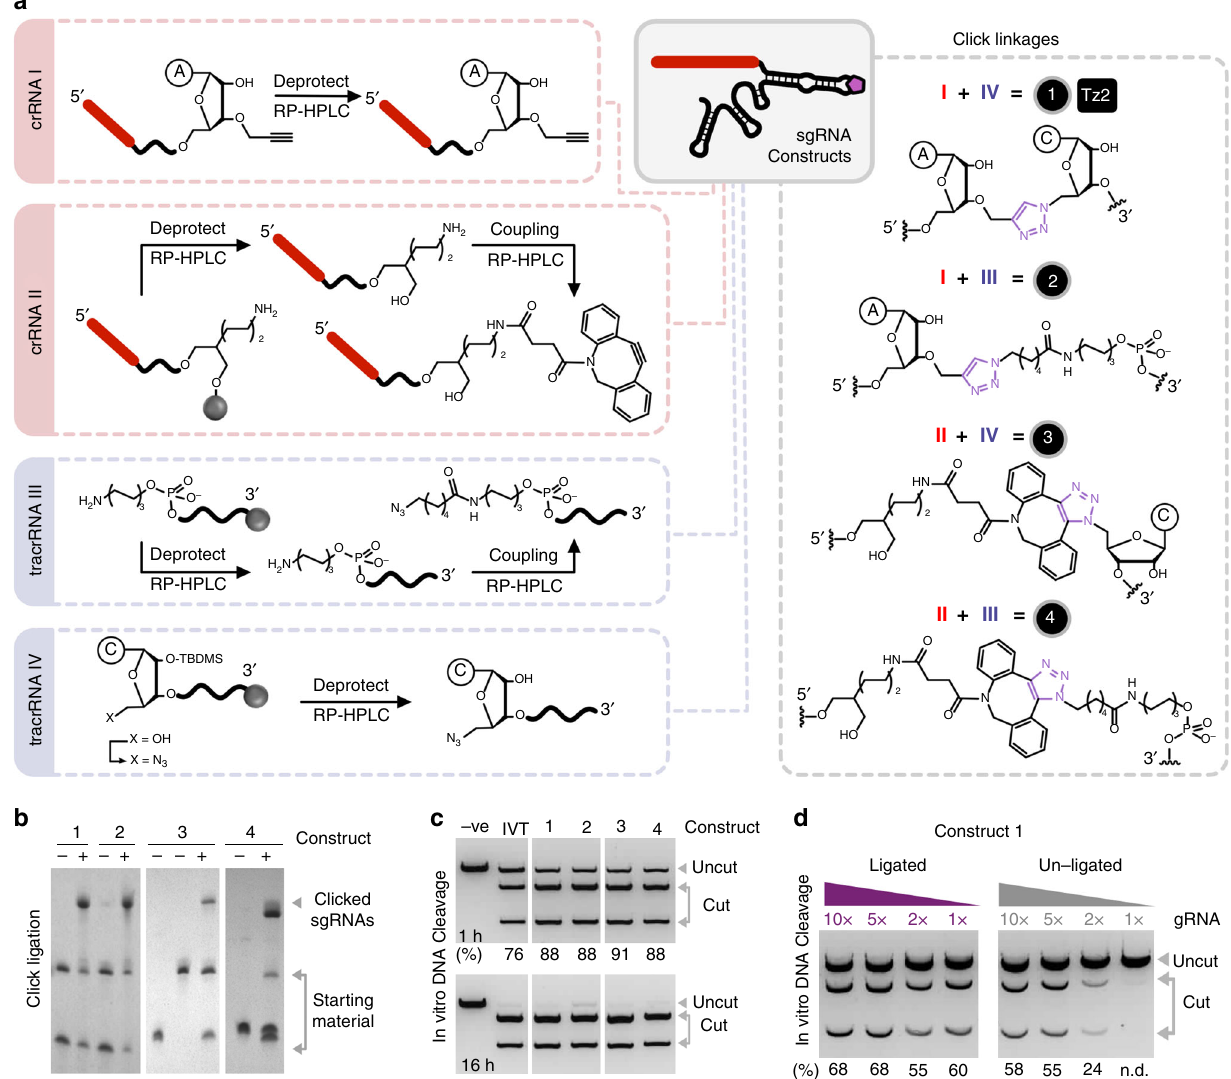
Fig. 1 Synthesis and in vitro DNA cleavage activity of clicked crRNA – tracrRNA constructs. a illustrates the steps involved in oligonucleotide synthesis